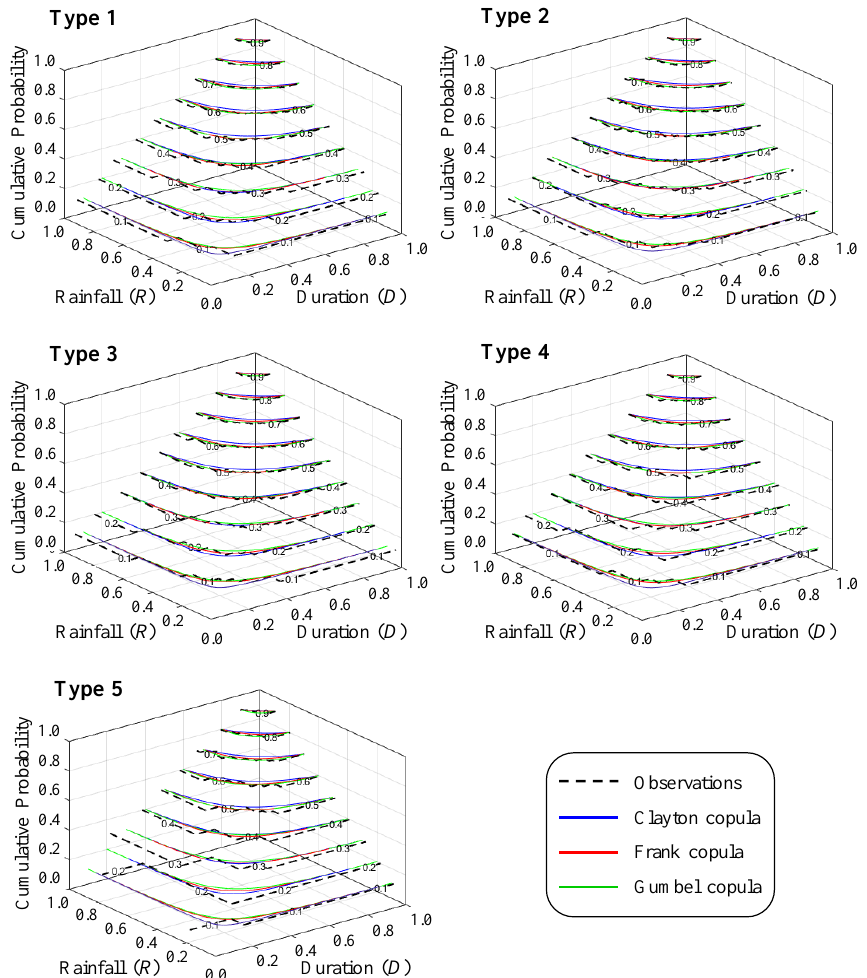
Figure 9. Copula functions for different rainfall types in summer.